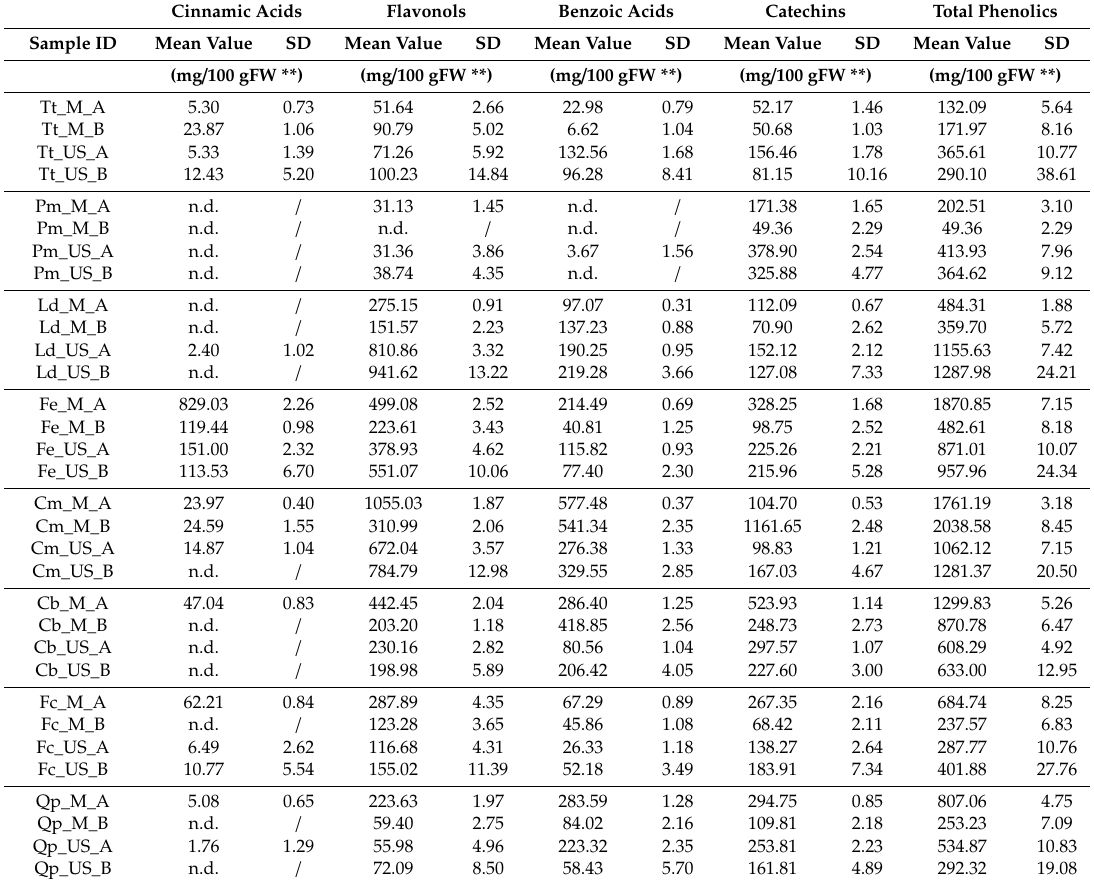
Table 4. Bioactive classes and total phenolics in the analyzed